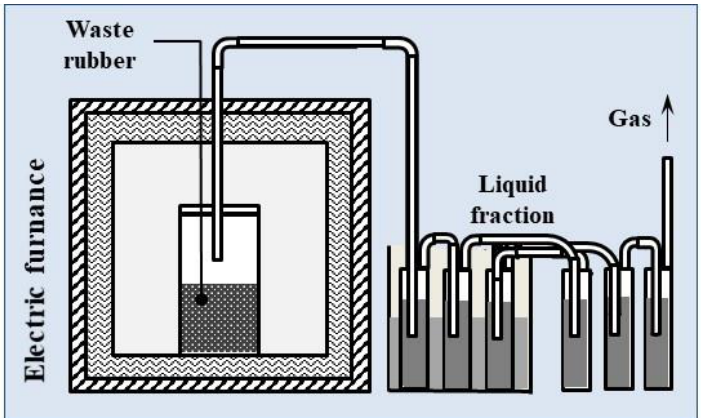
Figure 2. Scheme of pyrolysis laboratory-scale set-up.